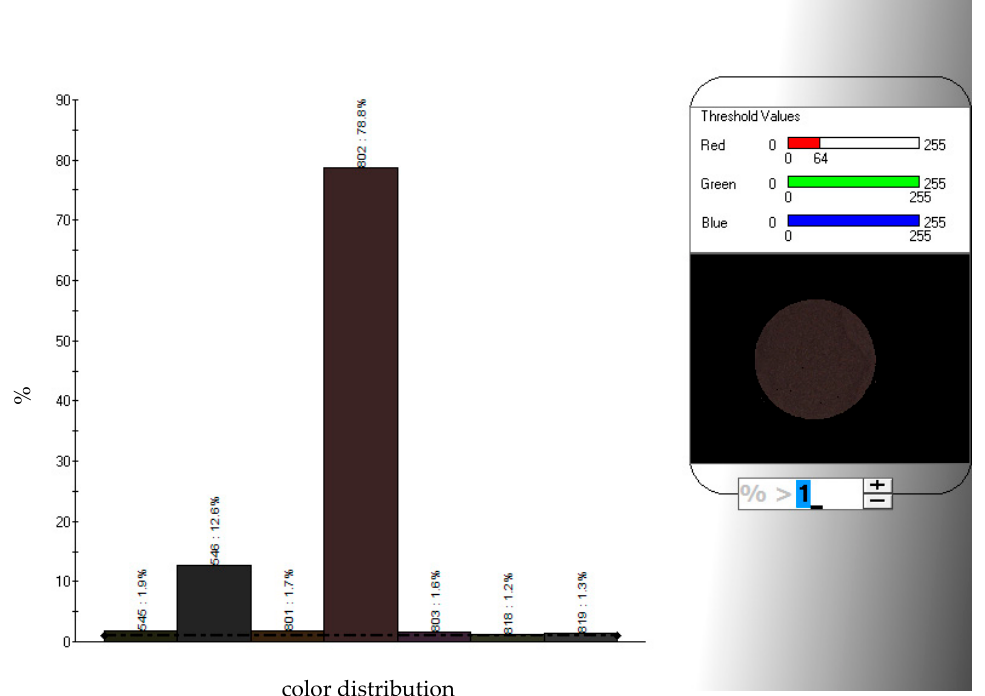
Figure 5. Detailed colour analysis of black garlic from organic cultivation (EBG) using the instrumental method (“electronic eye”) .